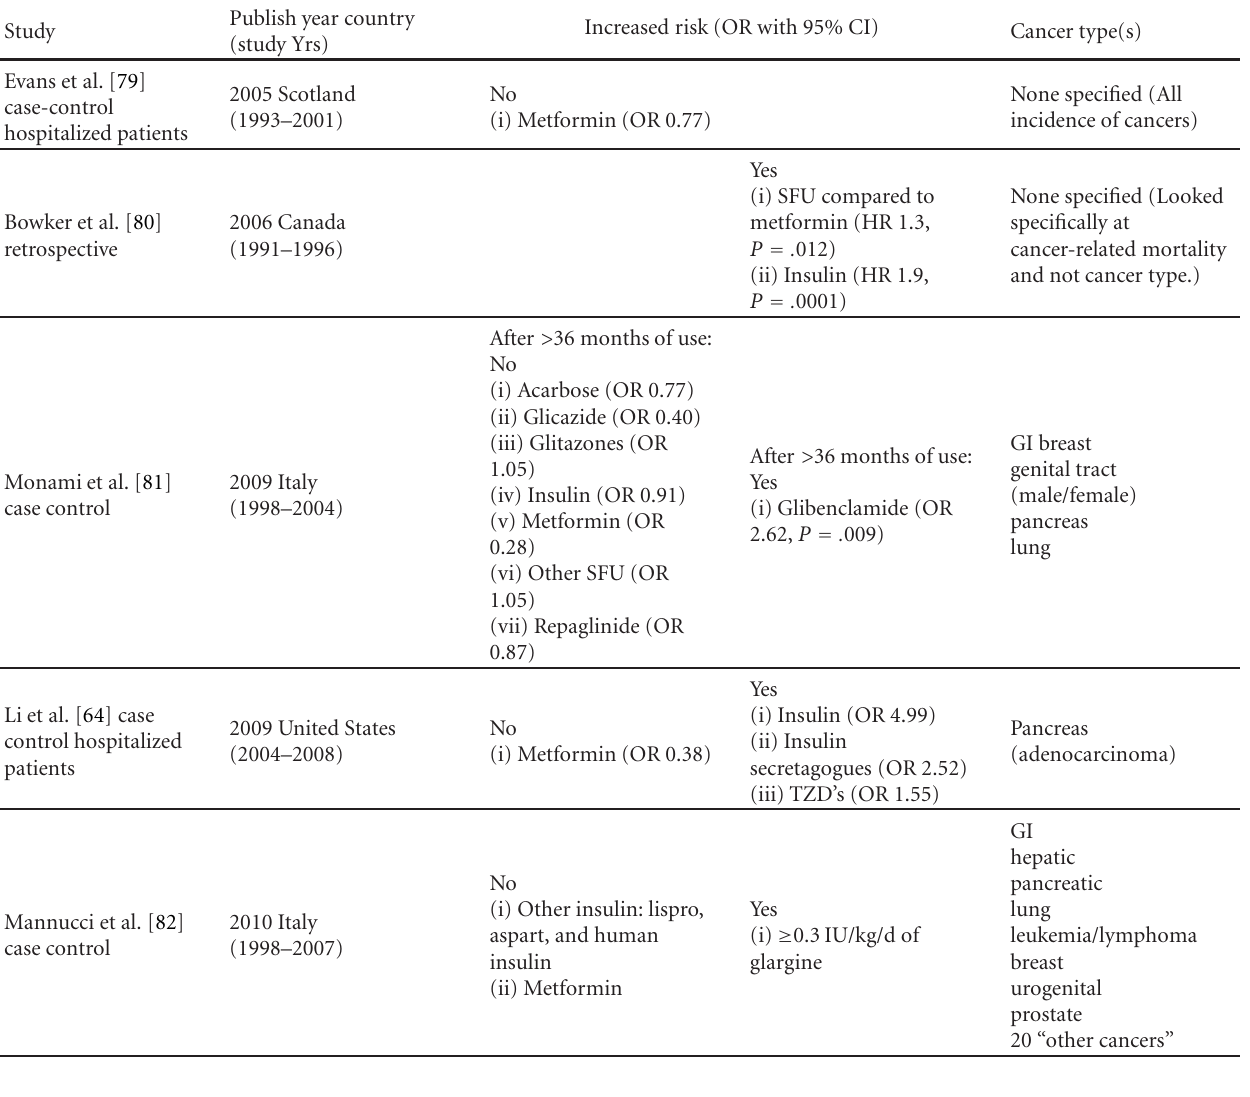
Table 1: Cancer risk with oral agents and insulin